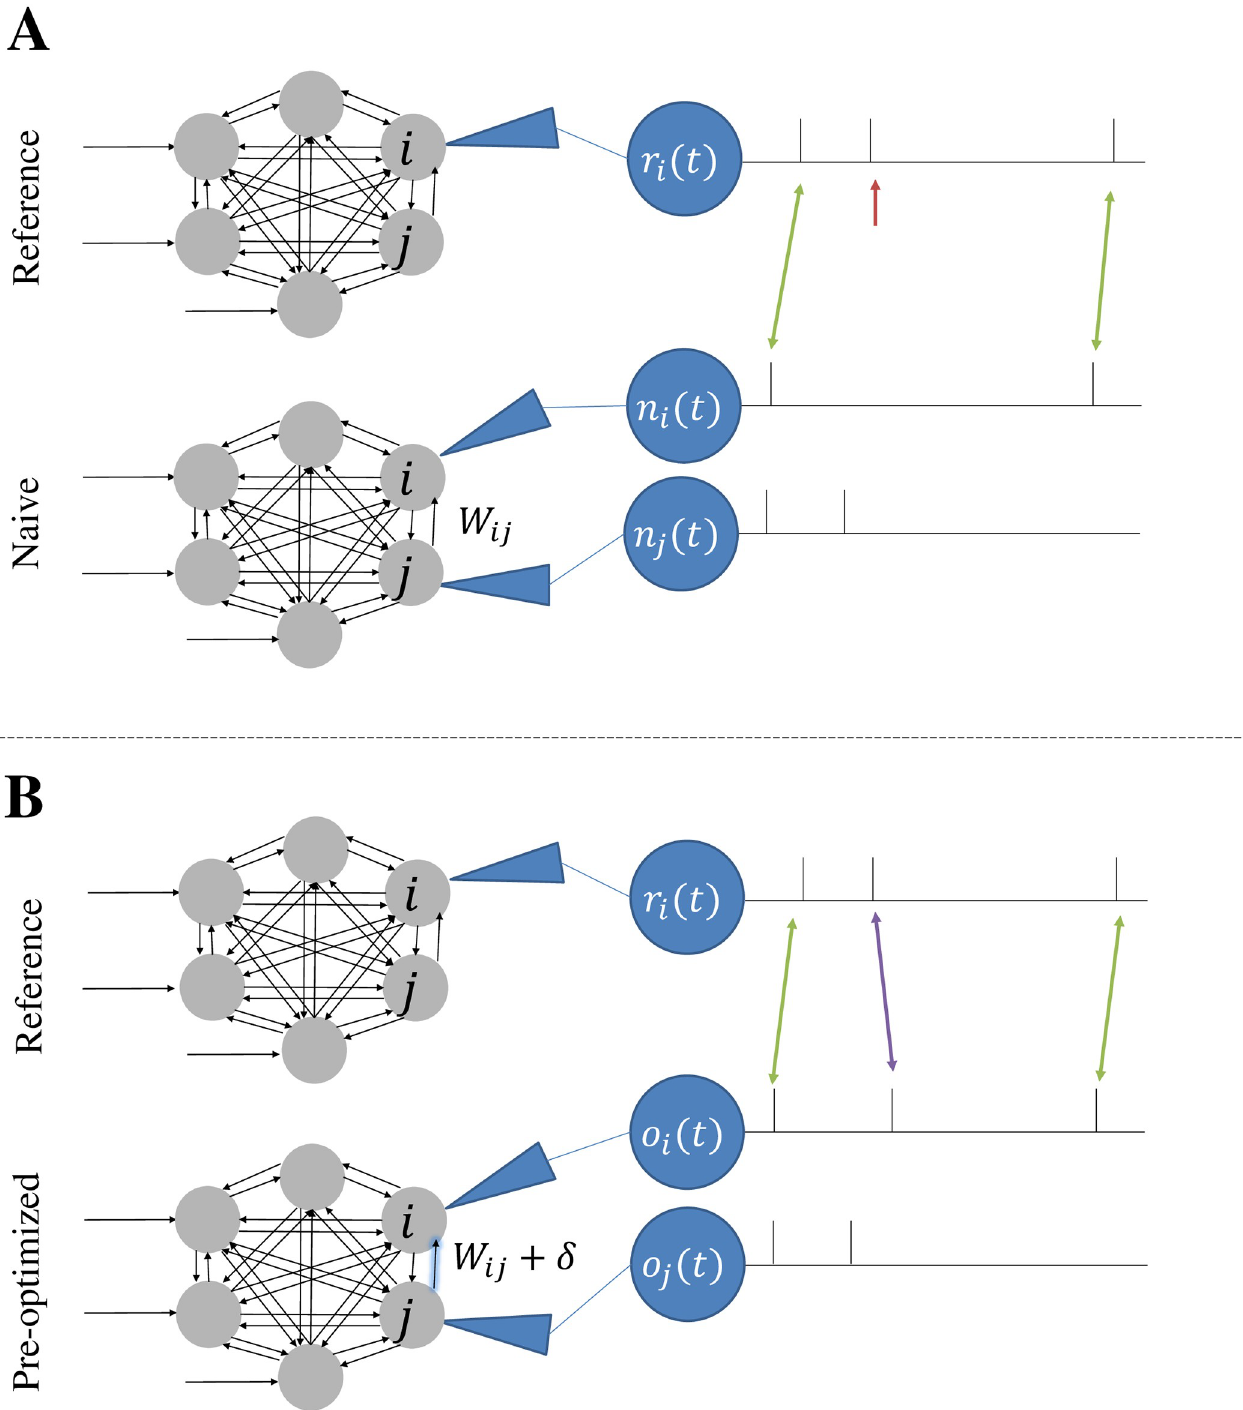
Fig 2. Pre-Synaptic Pool Modification (PSPM) learning rules. ( A ) Spike trains for the i neuron from the reference outputs r ( t ) and the naive network th i outputs n i ( t ) before weight alteration. The j th neuron’s spike train is also shown for the na ï ve net n j ( t ). The red arrow identifies a spike in the reference output which is initially unpaired. ( B ) Because the j neuron of the na ï ve network experiences a spike at a time shortly before the unpaired spike in the reference th spike train, the synaptic weight from j to i is increased (blue arrow), ideally resulting in a new spike in the i neuron’s spike train. In the next simulation th round, this new spike matches with the formerly unpaired reference spike, as indicated by the purple arrow. Networks receive this treatment for every spike that remains unpaired after application of the dynamic program